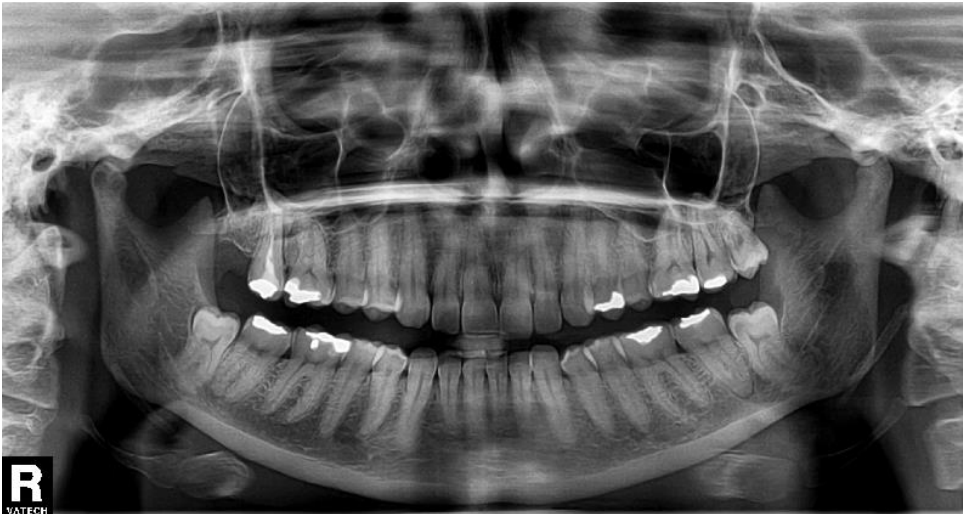
Figure 5. The orthopantomogram of the patient 4. Tooth No. 38 is in infra-occlusion, with a semilu- nar burnout distally. burnout